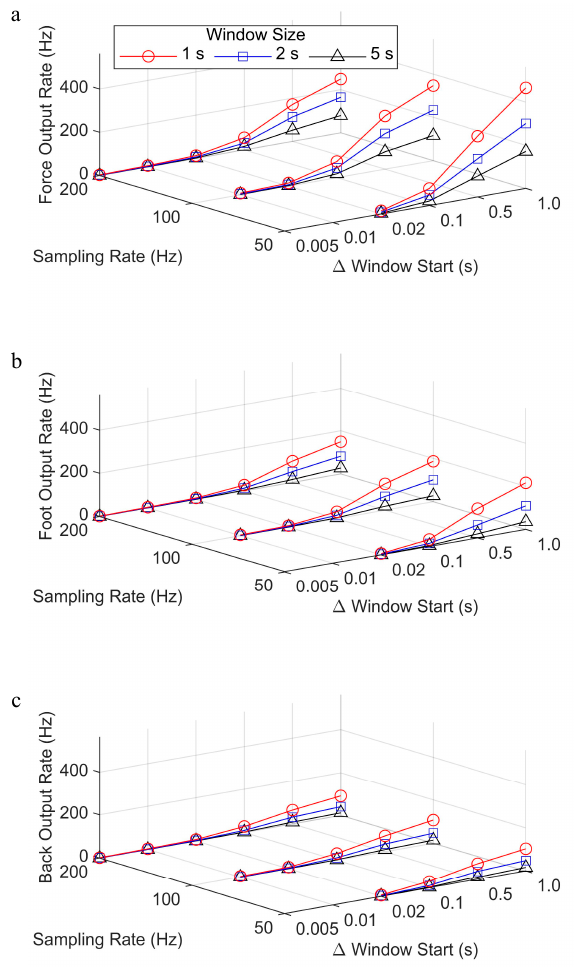
Figure 3. Output rate for the ( a ) force, ( b ) foot, and ( c ) back gait event detection methods, processed with different sampling rate, window size, and change in window start time parameters.